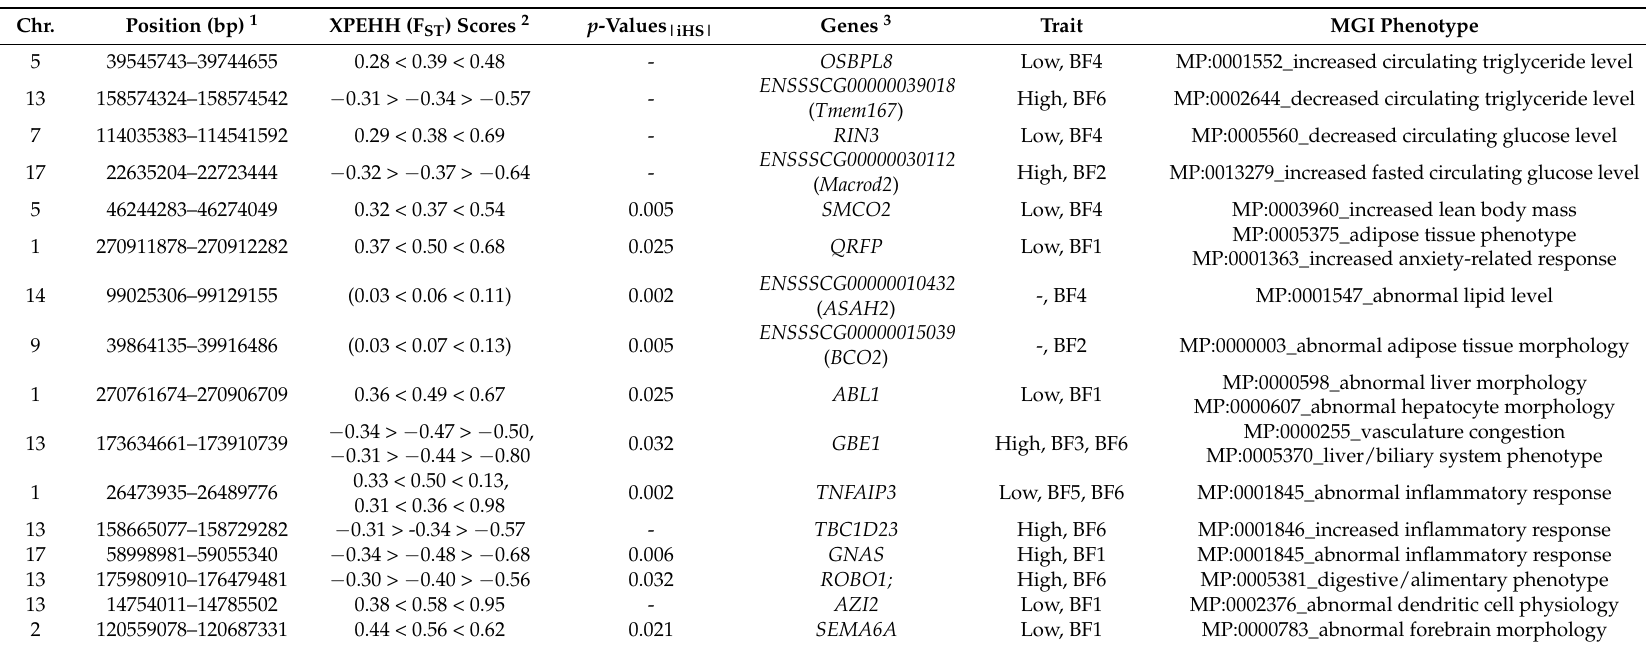
Table 1. Summary of results from functional annotation analysis of the trait-specific selection signatures based on the international database of Mouse Genome Informatics (MGI)